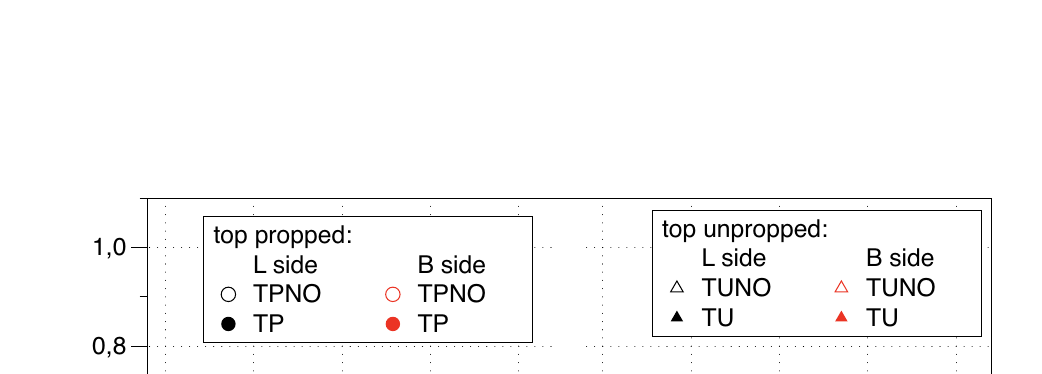
Figure 15. Dependency on the excavation depth H e of the normalised distance of the maximum settlement location y m / PIZ from the edge of the excavation.